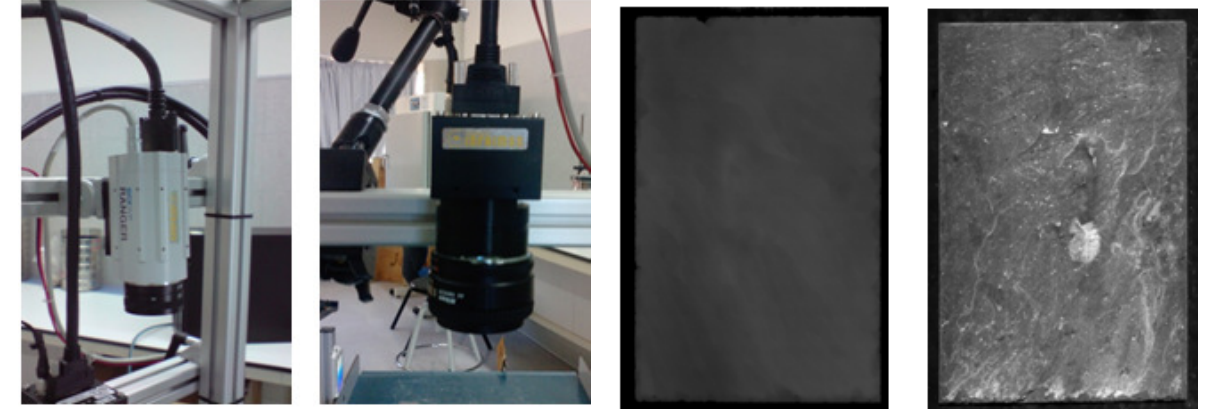
Figure 2. The 3D laser scanner and the 2D linear camera (left) with sample images for each